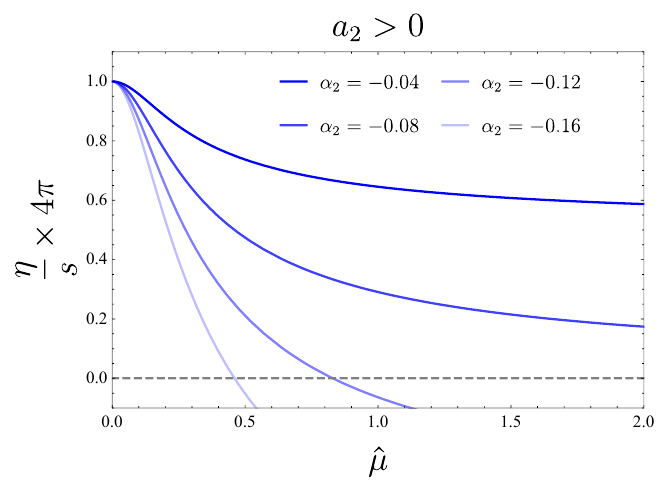
= β = 0 and α 0 in d = 4 . 1 2 <